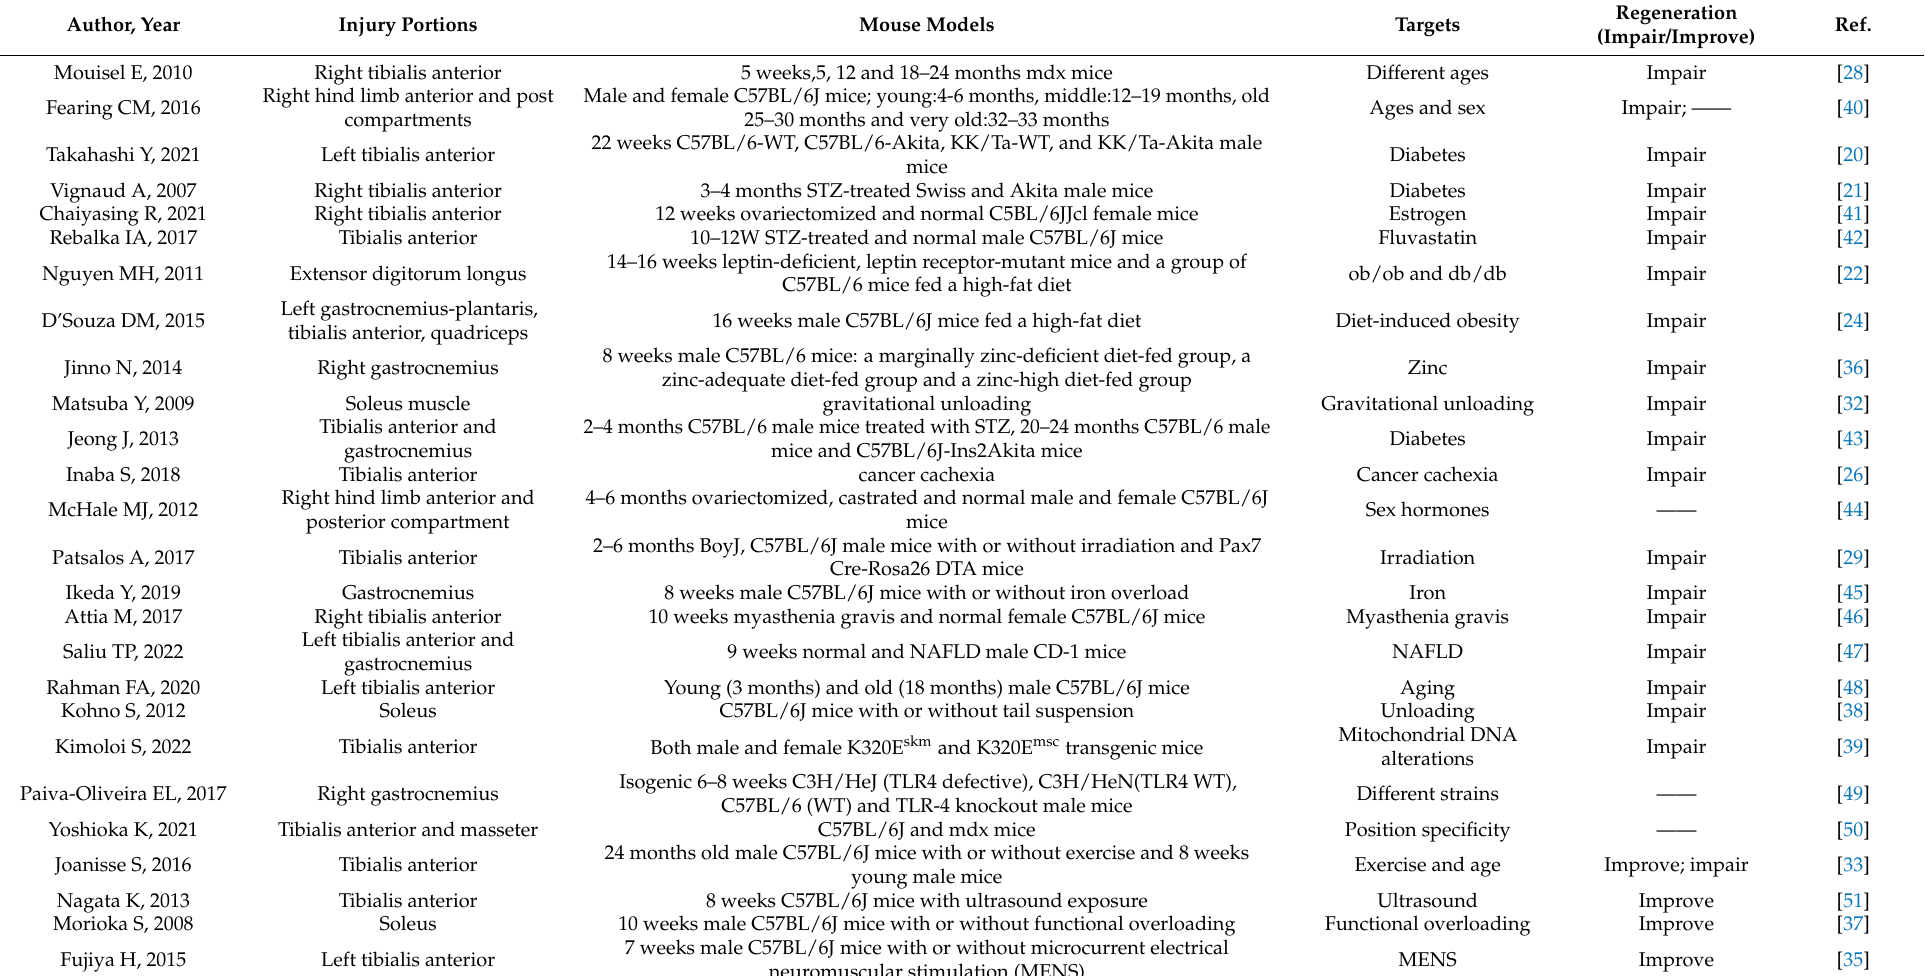
Table 1. Different mice models on CTX-induced regeneration in skeletal